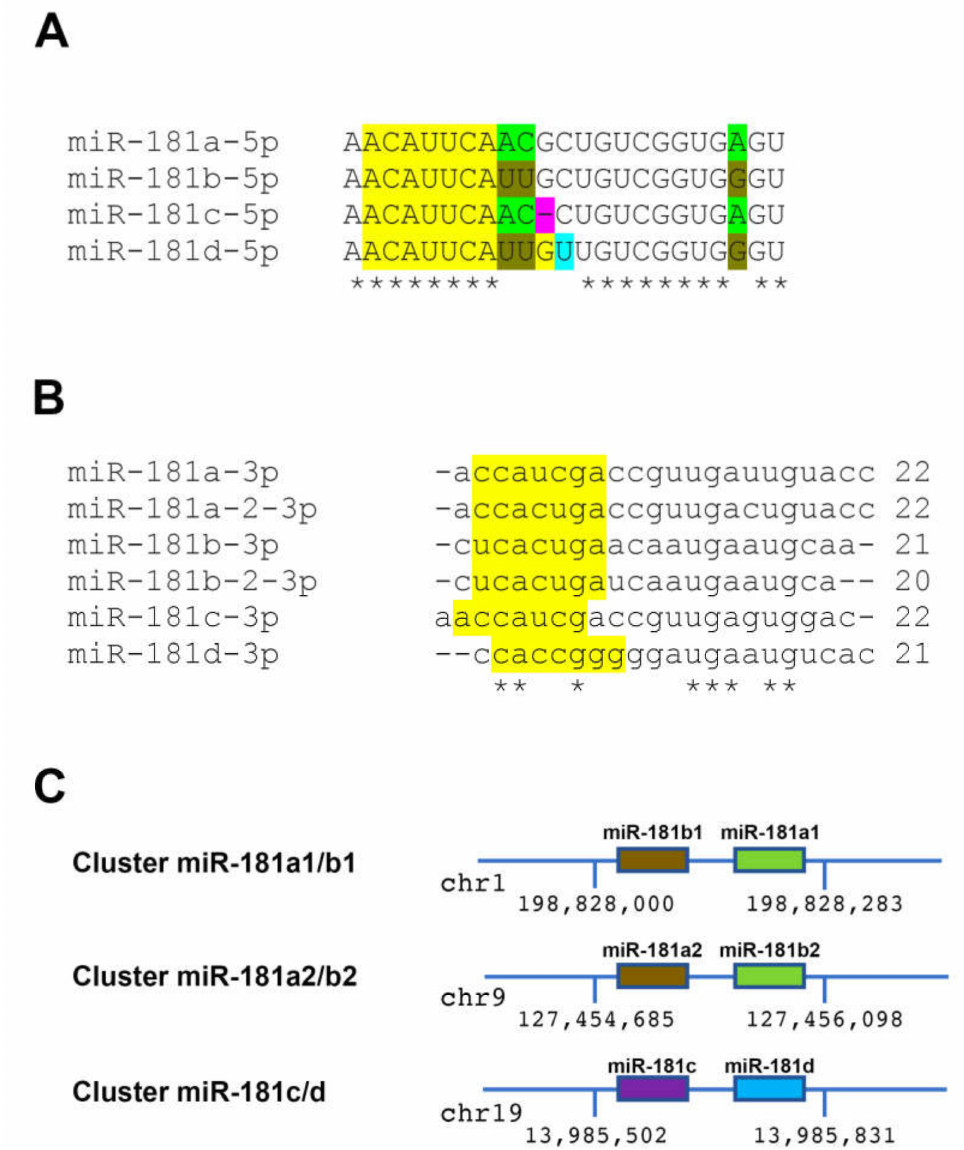
Figure 1. The miR-181 family in the human genome. ( A ) Sequence alignment of the four di ff erent 5p mature sequences. The seed is identical in all four 5p members and is labeled in yellow. The three bases that di ff er between miR-181a and miR-181b are labeled in green and brown, respectively. The single nucleotide positions that constitute the only di ff erence in the miR-181a / c and miR-181b / d pairs are labeled, respectively in purple (in miR-181c) and light blue (in miR-181d). The asterisks mark the identical nucleotides. ( B ) Sequence alignment of the six di ff erent 3p mature sequences. The seed regions are labeled in yellow and the asterisks mark the identical bases. ( C ) Genomic organization of the three miR-181 clusters. Chromosomal position and genomic coordinates (hg19) are shown. Please note that the clusters are not drawn to